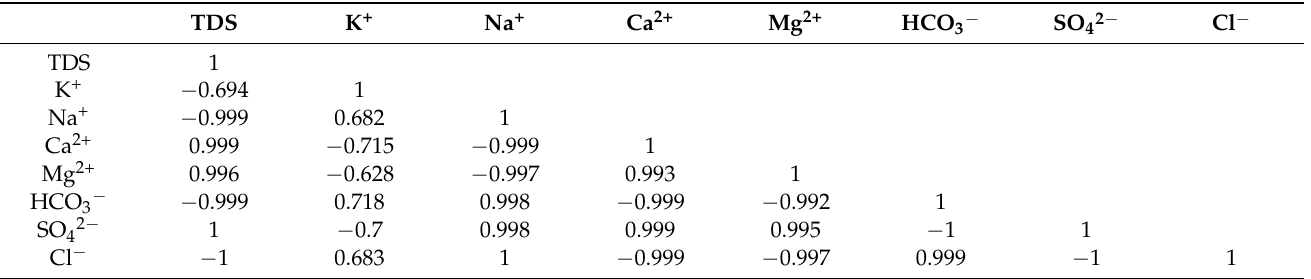
Table 2. Geothermal water sample ion correlation analysis (A).